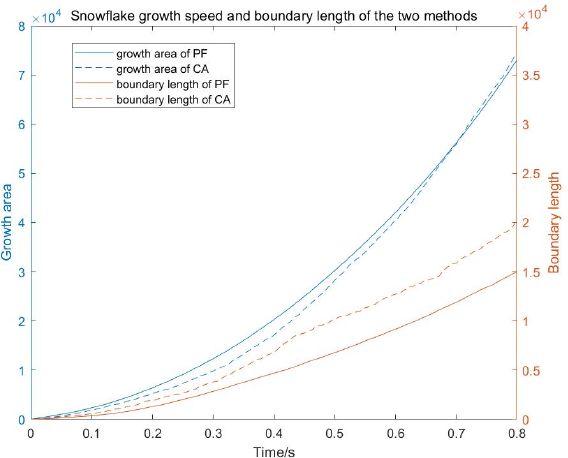
Figure 15. Snowflake growth speed and boundary length of the PF and CA methods.